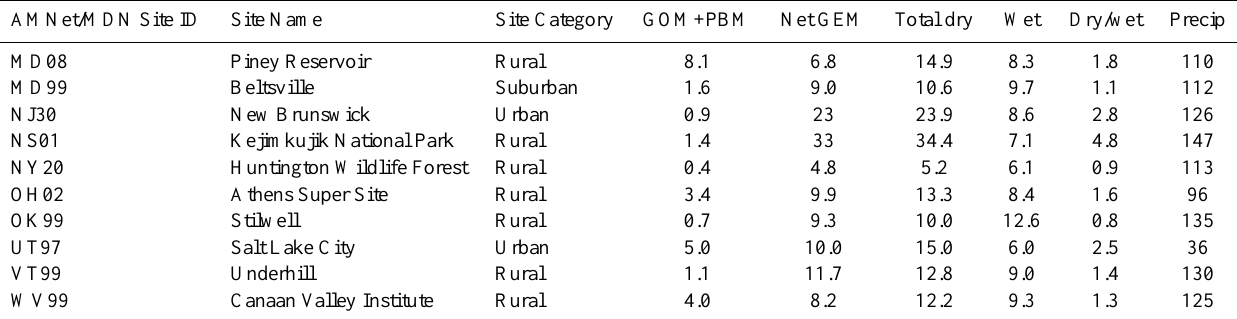
Table 3. Estimated annual dry deposition (µgm − 2 yr − 1 ) and measured annual wet deposition (µgm − 2 yr − 1 ) at AMNeT/MDN collocated sites. Three-year average annual precipitation amount (cm) is also